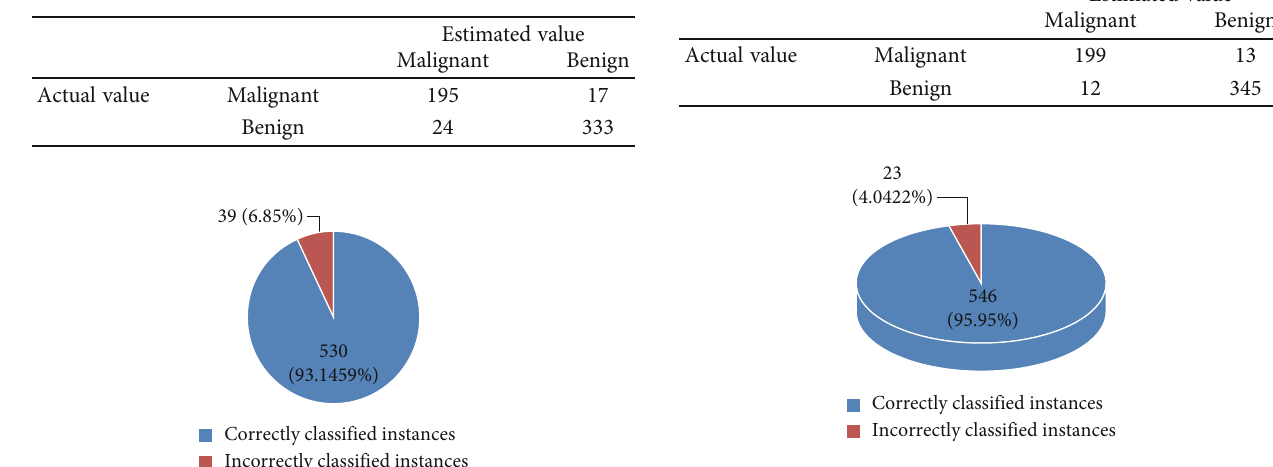
Figure 8: Accuracy and sensitivity information of the SVM technique. Table 5: Complexity matrix of the J48 technique.